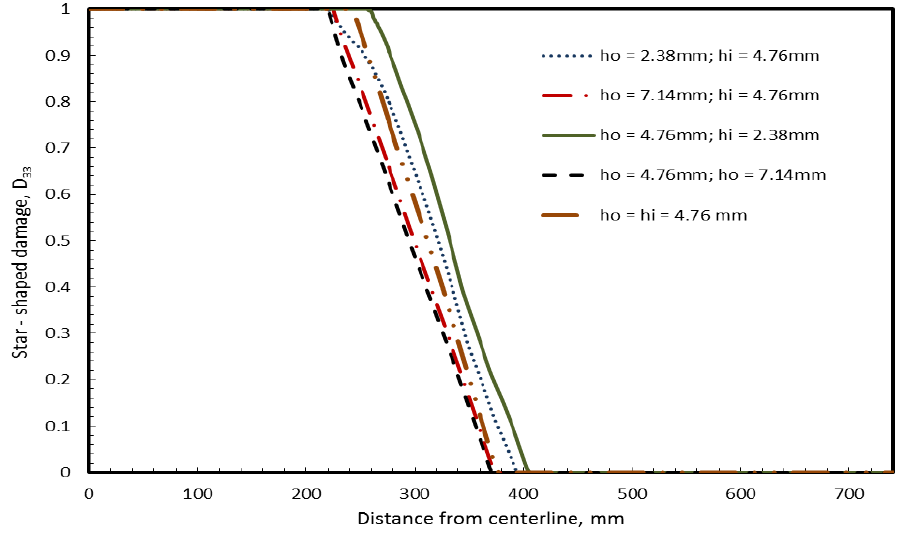
Figure 13. Effect of inner and outer plies thickness on Damage variable D at surface S4 for large missile (round end)